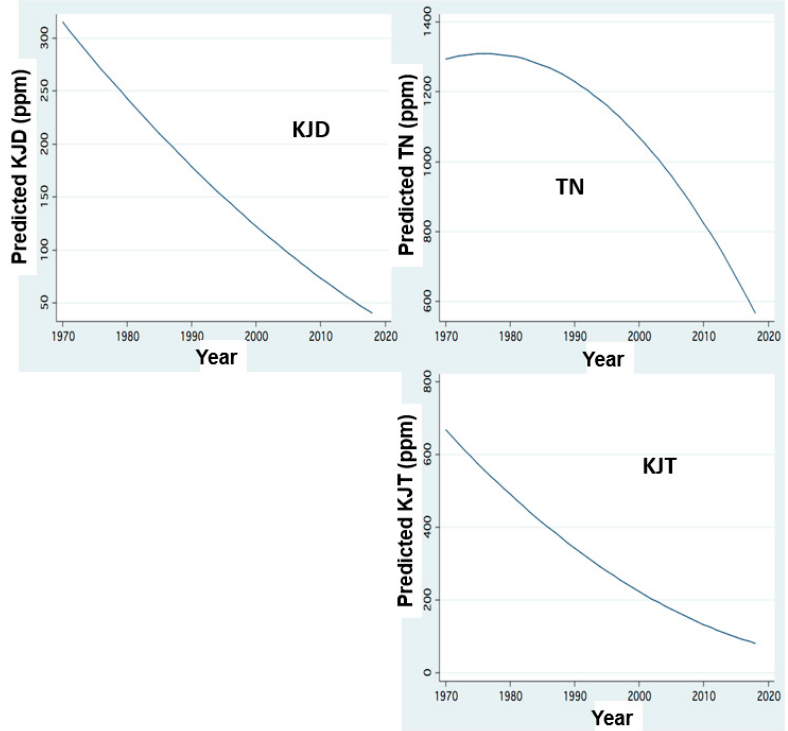
Figure 9. Temporal changes of N loads: FP regression between annual (1970–2018) Load inputs (ton) through Jordan discharge of Kjeldhal Dissolved (KJD), Total Nitrogen (TN), and Kjeldhal Total (KJT) and years.